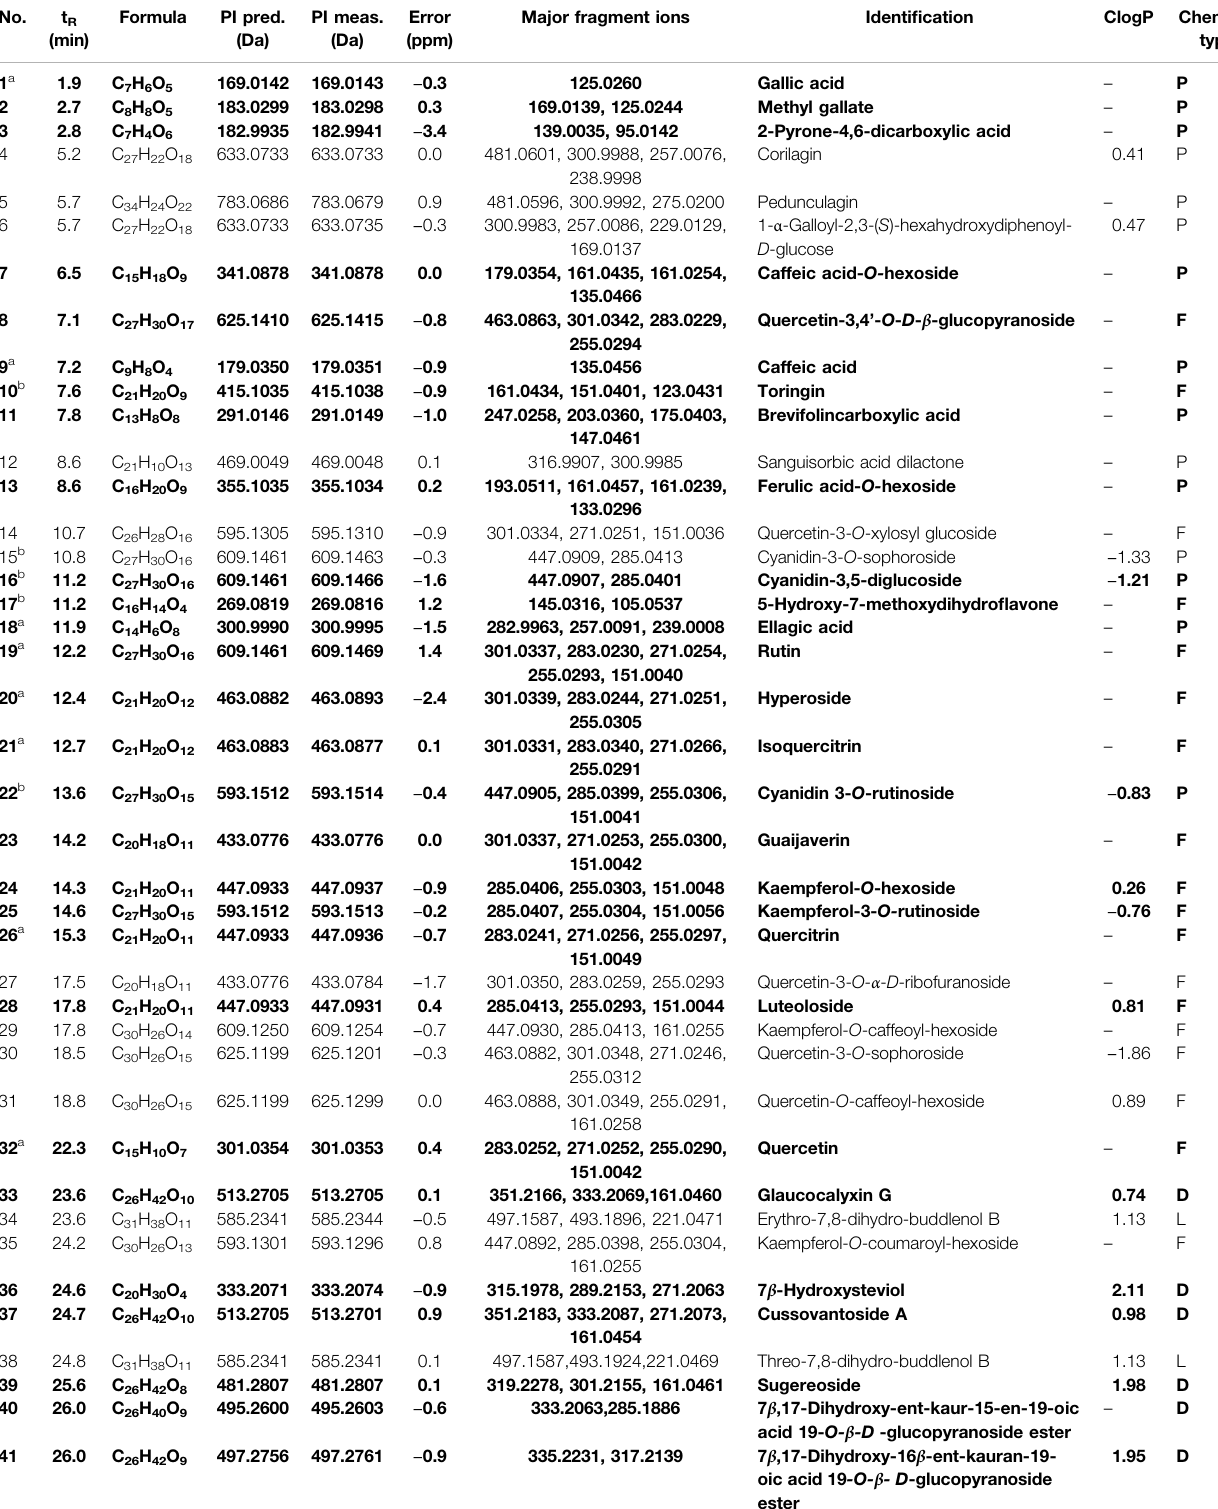
TABLE 1 | Characterization of chemical components of Rubus chingii var. suavissimus by UPLC-Q/TOF-MS.